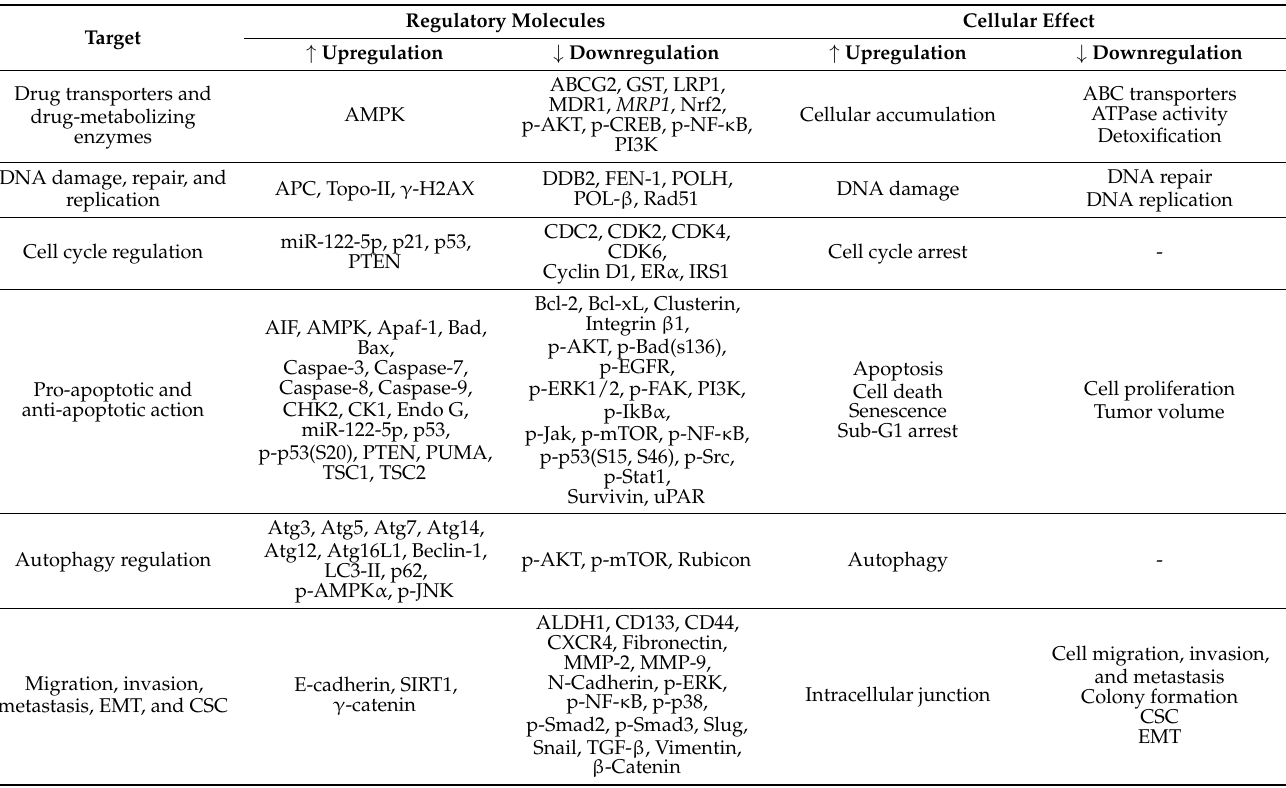
Table 1. RES-induced regulation of cellular signaling molecules and gene regulatory factors in various drug-resistant cancer